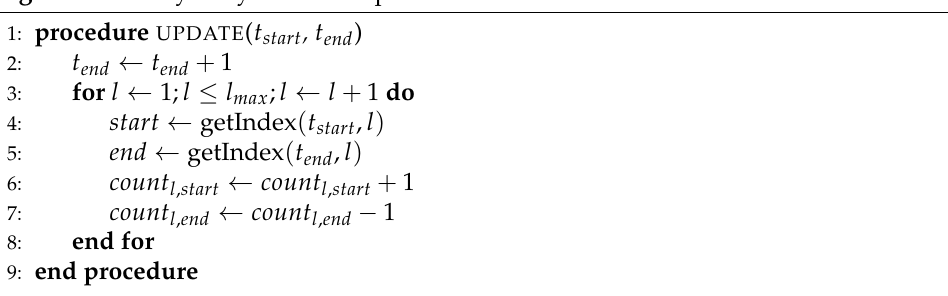
Figure 13. KEP Tree Update for Vehicle 4. Algorithm 7